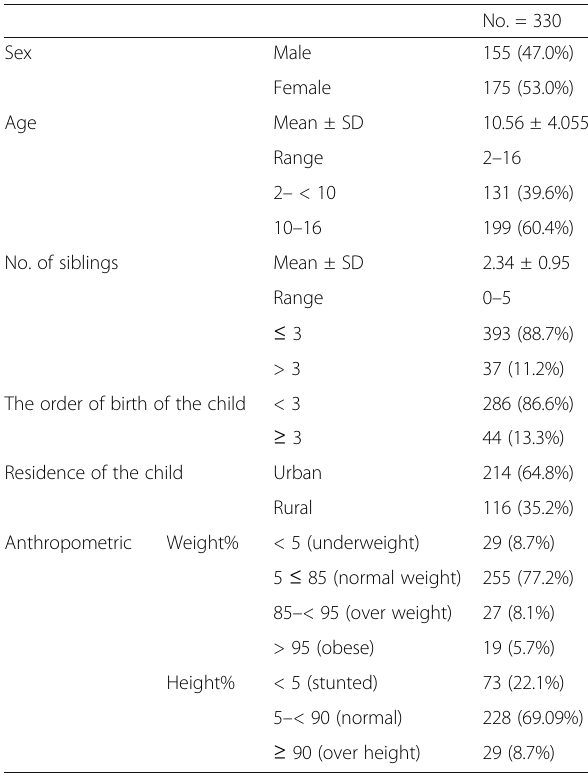
Table 1 Descriptive data of studied group patients regarding personal data